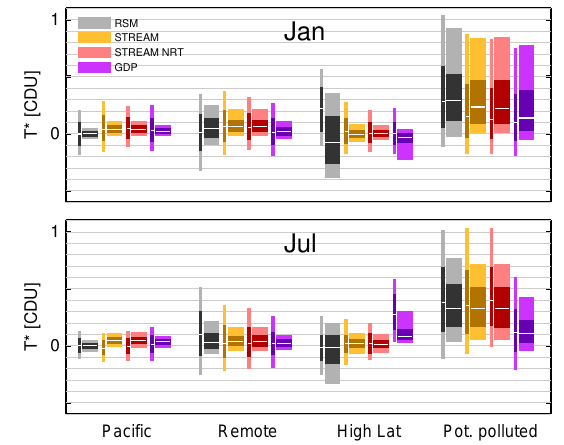
Figure 12. Regional statistics of GOME-2 tropospheric residues T ∗ from different algorithms for January (top) and July (bottom) 2010. Conventions as in Fig.